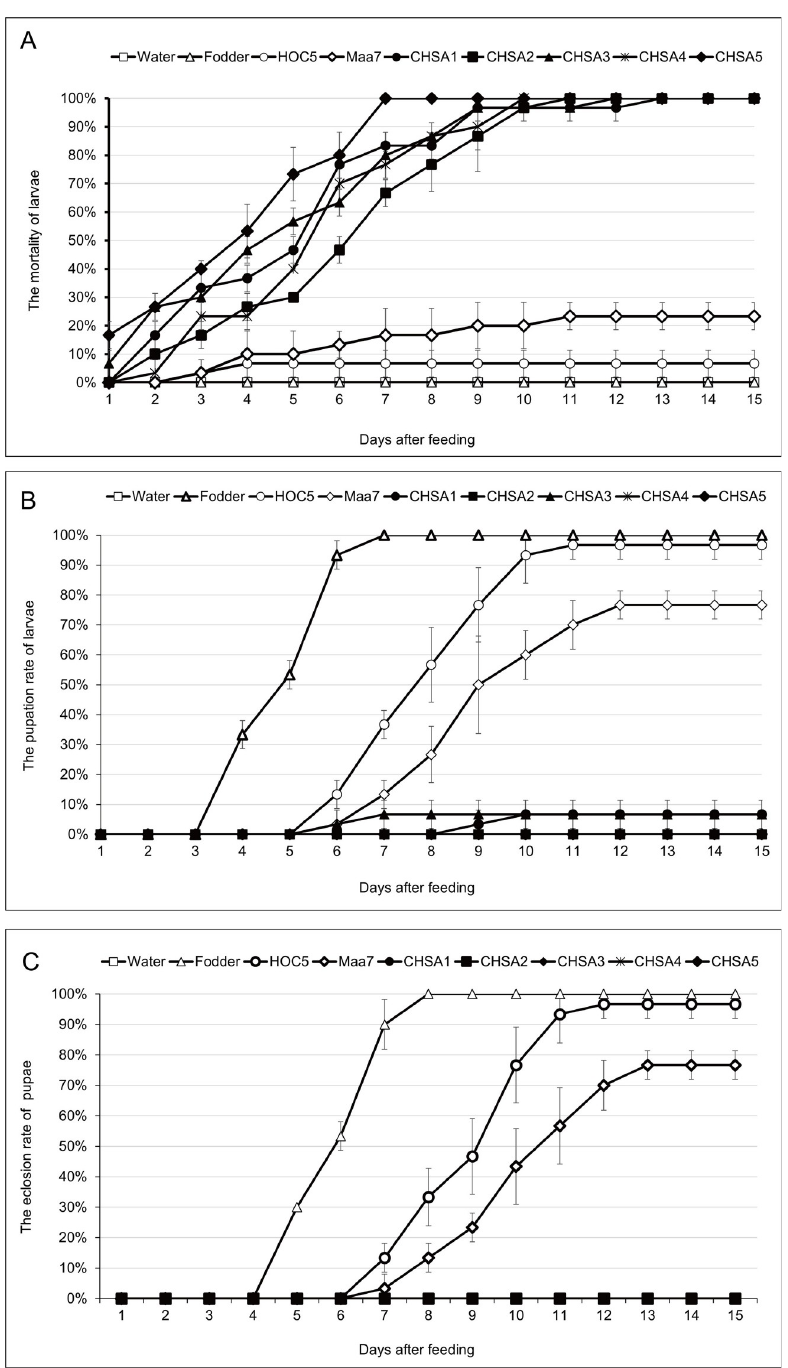
Fig 1. Mortality (A), pupation (B), and eclosion rates (C) of Aedes aegypti fed with chsa RNAi recombinant Chlorella . Water: larvae fed with water; Fodder: larvae fed with fodder; HOC5: larvae fed with wild Chlorella vulgaris HOC5; Maa7: larvae fed with empty plasmid Maa7IR/XIR transgenic Chlorella strain; CHSA1 to CHSA5: larvae fed with Maa7IR/CHSAIR transgenic Chlorella strains CHSA1 to CHSA5. Each treated or control group contained ten Aedes larvae, and the experiments were performed in triplicate for 15